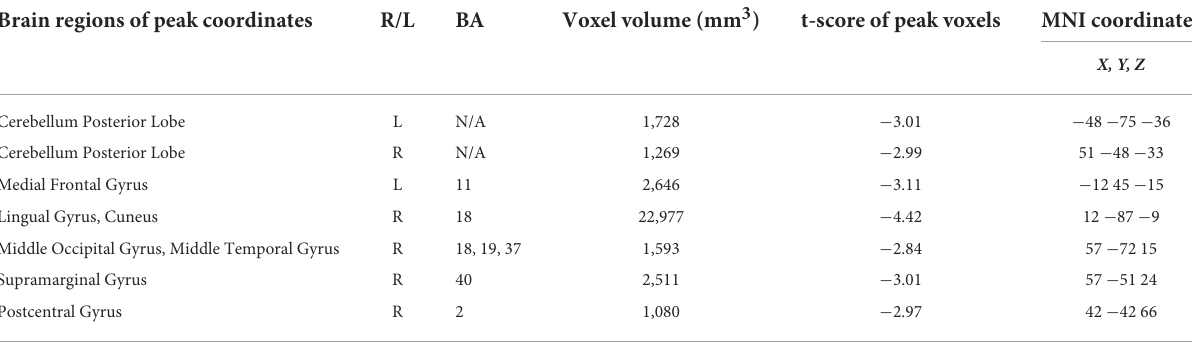
TABLE 1 The PerAF differences between patients with alcohol dependence and